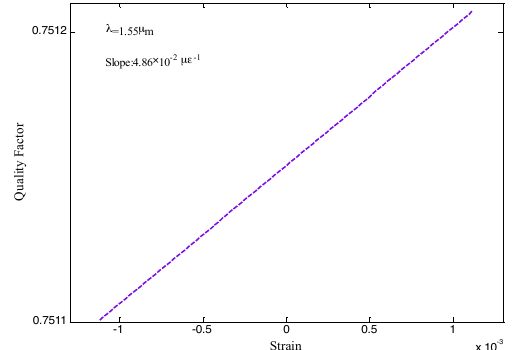
Figure 8: Quality factor as a function of strain for the fiber with initial structural